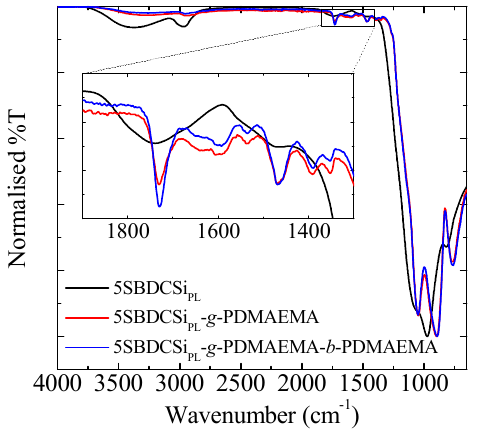
Figure 5. Normalised IR spectra of a CO 2 plasma-treated 5SBDCSi film (black trace) in comparison to 5SBDCSi after performing a SIP in the presence of a SI for 30 min (red trace), followed by chain extension for a further 30 min (blue trace).